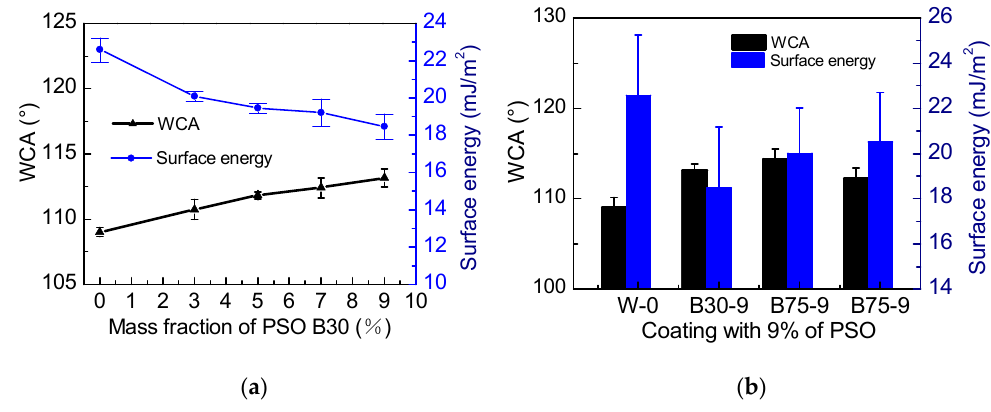
Figure 4. ( a ) The effect of PSO addition amount on water contact angle (WCA) and surface energy of silicone topcoat, ( b ) the effect of PSO viscosity on WCA and surface energy of silicone topcoat. According to the Owens two-liquid method, we calculated the surface energy of the coating [23].